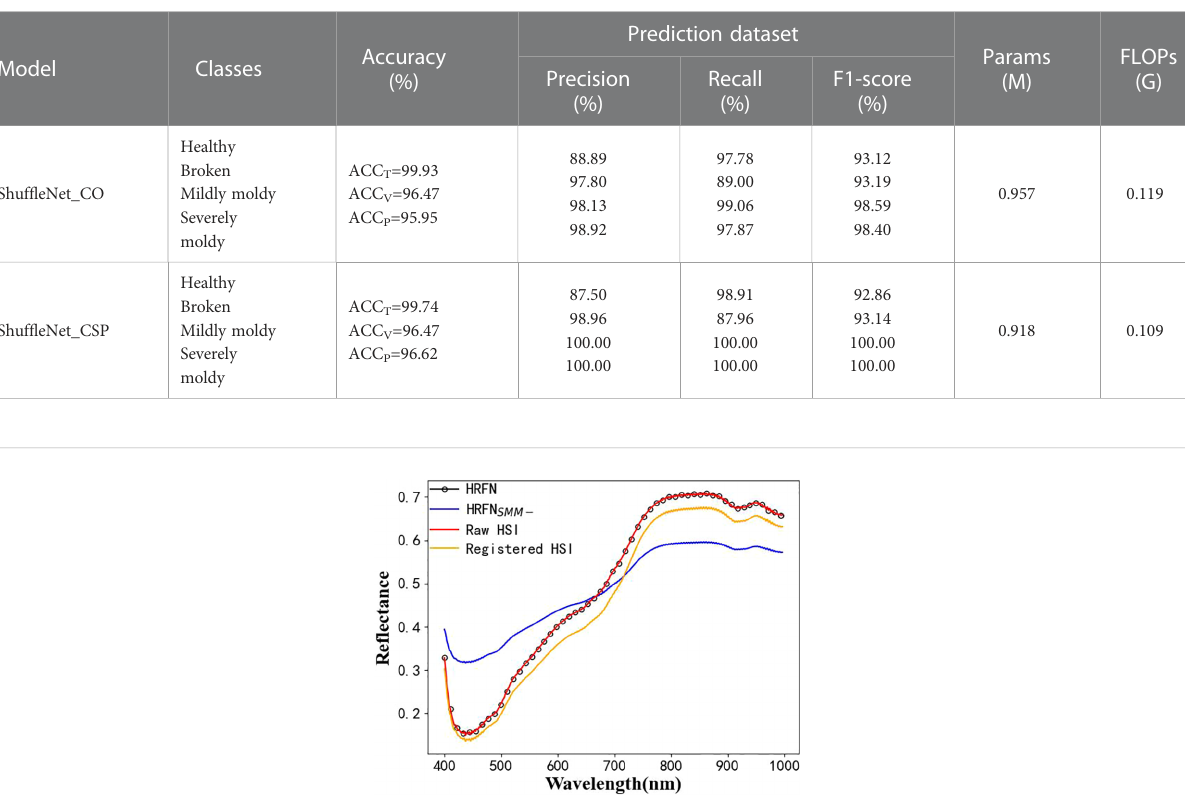
TABLE 5 Recognition results based on SHUFFLENET adding CO and CSP .